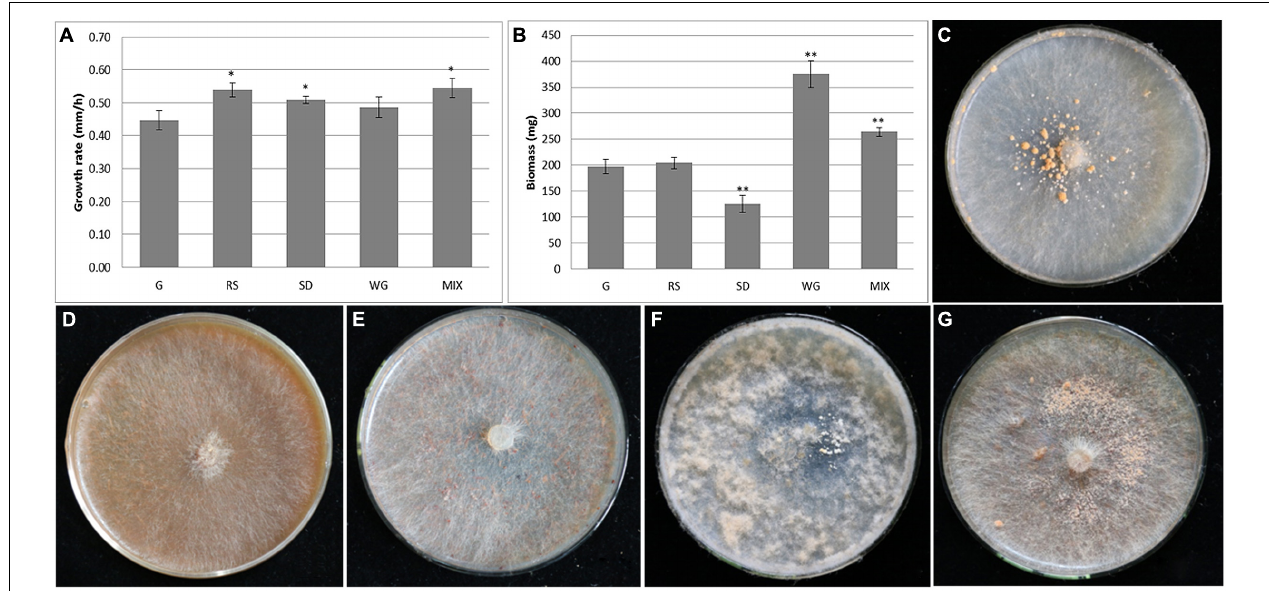
FIGURE 1 | Growth potential of Morchella importuna on different media. Mycelium growth rate (A) and biomass (B) were also measured on the five different media; significant differences are marked by asterisks, * p < 0.05, ** p < 0.01. The colony morphology of M. importuna was examined on CYM medium (termed G) (C) ,